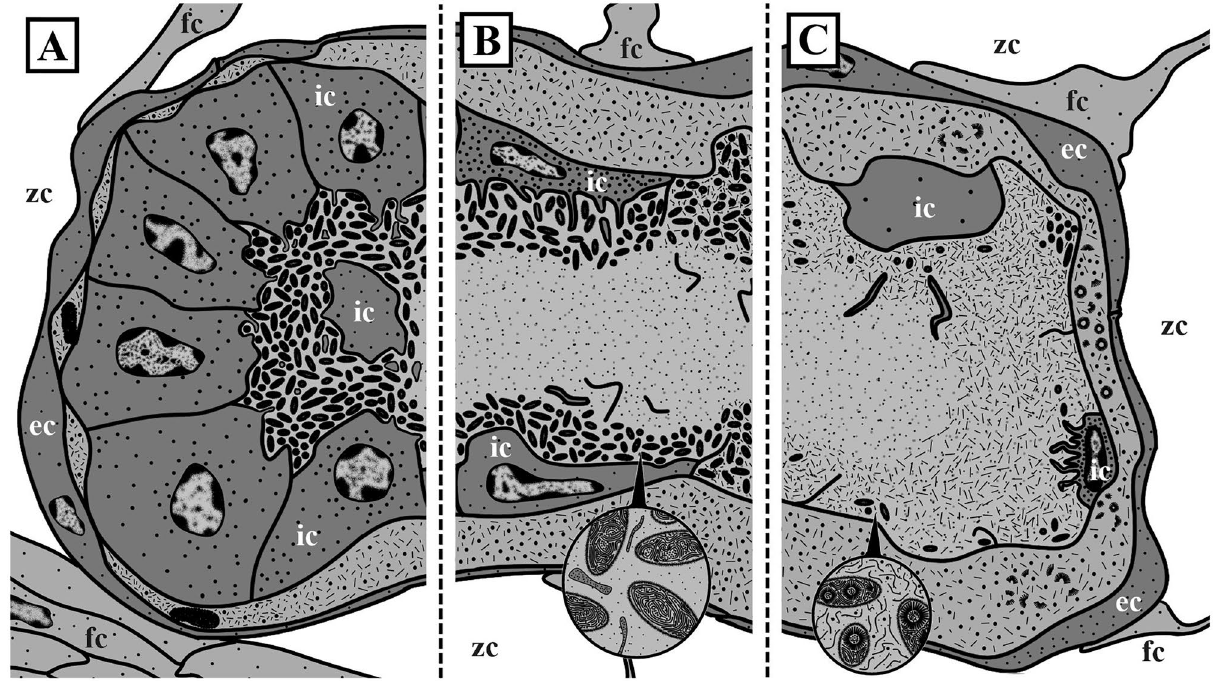
Figure 10. Schemes of funicular bodies of Dendrobeania fruticosa at various stages of degradation (from left to right: early-, middle- and late-advanced), showing changes in their structure accompanied by bacterial degradation and putative VLP appearance (magnified sector in B ) and self-construction of spherical complexes inside bacteria (magnified sector in C ) and inside ILS. Note continuous ‘double’ membrane between internal cavity of funicular body and intercellular space, remaining after collapse of the inner cell layer. ec cells of external layer, fc funicular cell, ic cells of inner layer, zc zooidal